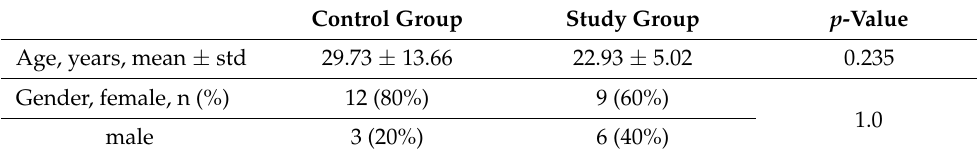
Table 2. Characteristics of patients in the test (n = 15) and control groups (n = 15). Control Group Study Group p -Value Age, years, mean ± std